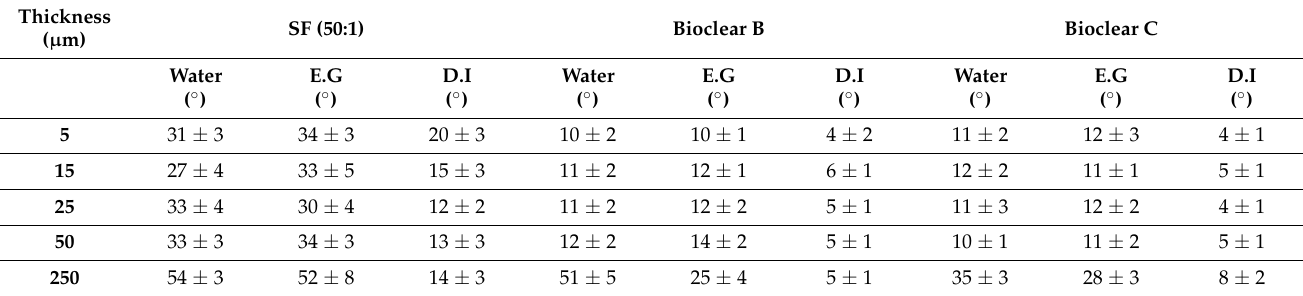
Table A3. SA values of water, ethylene glycol, and diiodomethane of soft PDMS surfaces with different thicknesses. Above 50 µ m a significant increase in SA is observed for water and EG on all PDMS types. This indicates that the substrate softness plays a key role and confirms the soft wetting state on the